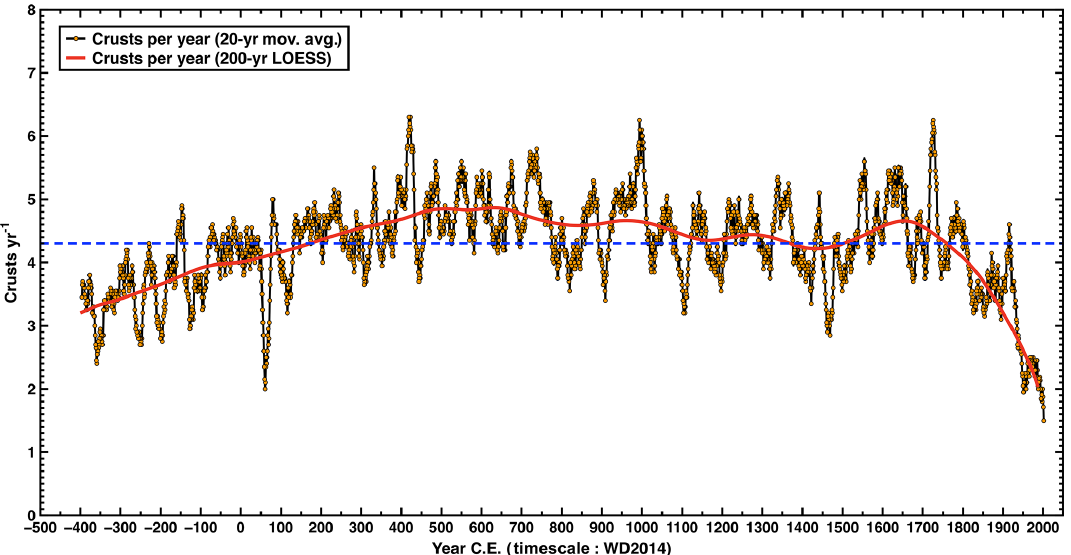
Figure 15. History of crust occurrence (crustsyear − 1 ) in the bubbly-ice zone of the WDC06A core that we studied in detail ( ∼ 120–577m depth); ages (CE) are from the WD2014 depth–age scale. A total of 10268 unique crusts were documented in the core, for an average rate of 4 . 3 ± 2 per year (dashed blue line). Data are shown as 20-year moving averages for ease of view, with an added 1st-order LOESS smoothing trend curve (200-year bin width). The sharp decline in crust prevalence after ∼ 1750CE may be due to observational biasing in the shallow firn and